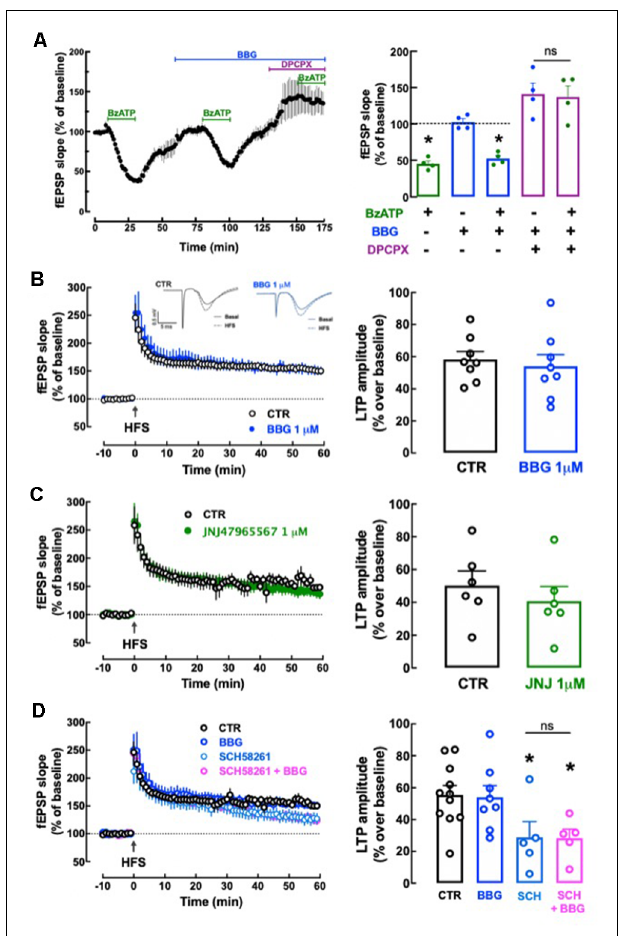
FIGURE 9 | Lack of direct effects of P 2X7 receptors on hippocampal synaptic plasticity or its modulation by A 2A receptors. (A) The P 2X7 R agonist BzATP (30 µ M) decreased synaptic transmission in Schaffer collaterals-CA1 pyramid synapses of hippocampal slices from adult rats (10–12 weeks